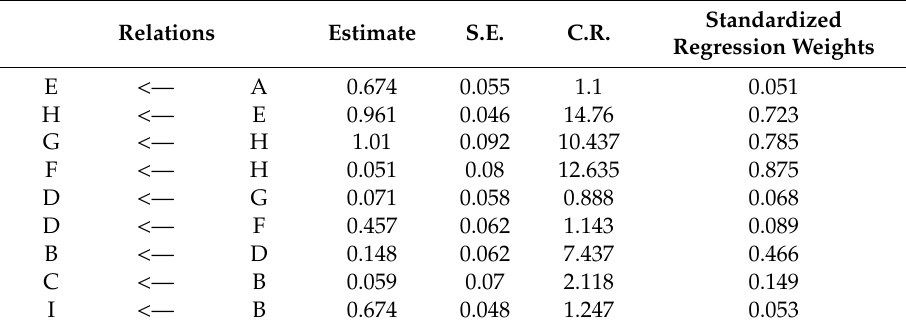
Table 5. Discriminant validity of the barriers to climate change adaptation. Relations